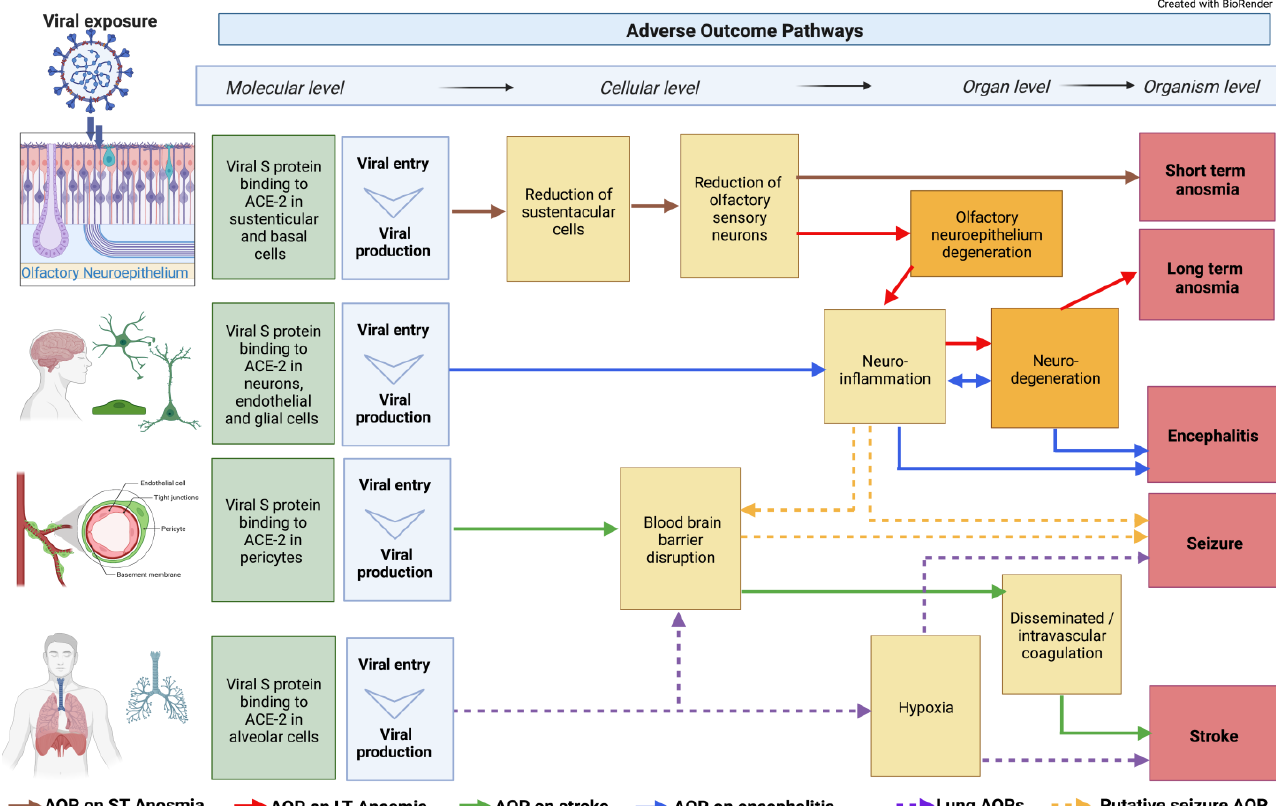
Figure 1. Integration of classical AOPs. Neuronal-related AOPs developed so far within the CIAO dedicated neuro working group integrated into an AOP network. Some of these AOPs are already uploaded on the AOP-Wiki, whereas others are only drafted outside the platform. The AOP network was built on 18 KEs, including 4 MIEs, 8 specialized (neuro-related) Kes, and 4 AOs. Two of these KEs were already available in the AOP-Wiki while the others were developed within the CIAO project. The dotted lines indicate not fully developed AOPs.